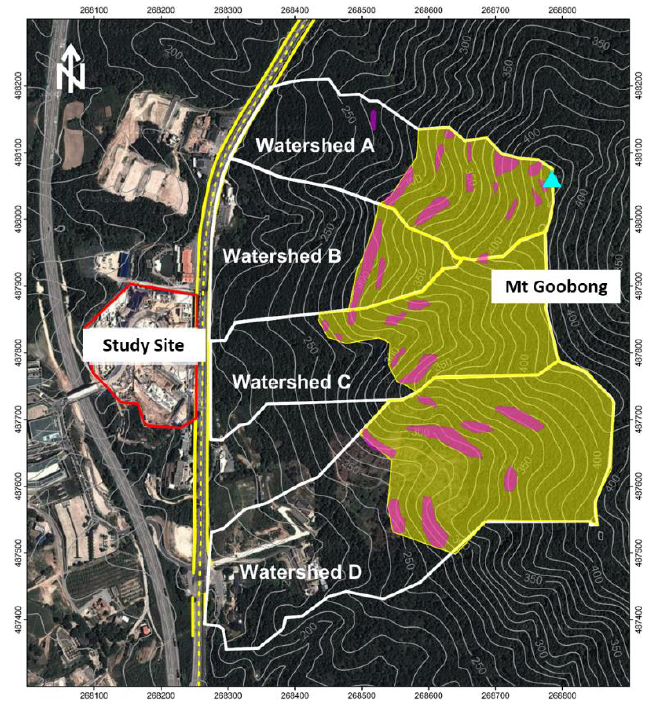
Figure 9. Map of effective rainfall collection areas (yellow) in each watershed. The purple areas denote initial mass distributions and the cyan triangle is the peak of Mt Goobong.